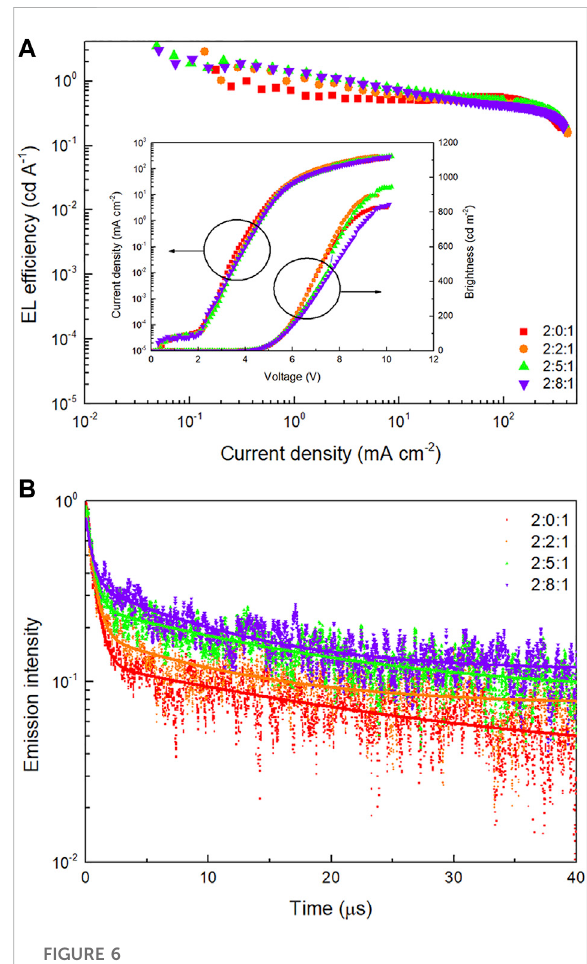
FIGURE 6 (A) EL ef fi ciency-current density ( η -J ) characteristics of devices with TAPC:TcTa:CzSi at different ratios. Inset: current density-brightness-voltage ( J-B-V ) characteristics of devices with TAPC:TcTa:CzSi at different ratios. (B) Transient EL decay curves of devices with TAPC:TcTa:CzSi at different ratios and corresponding biexponential fi tting